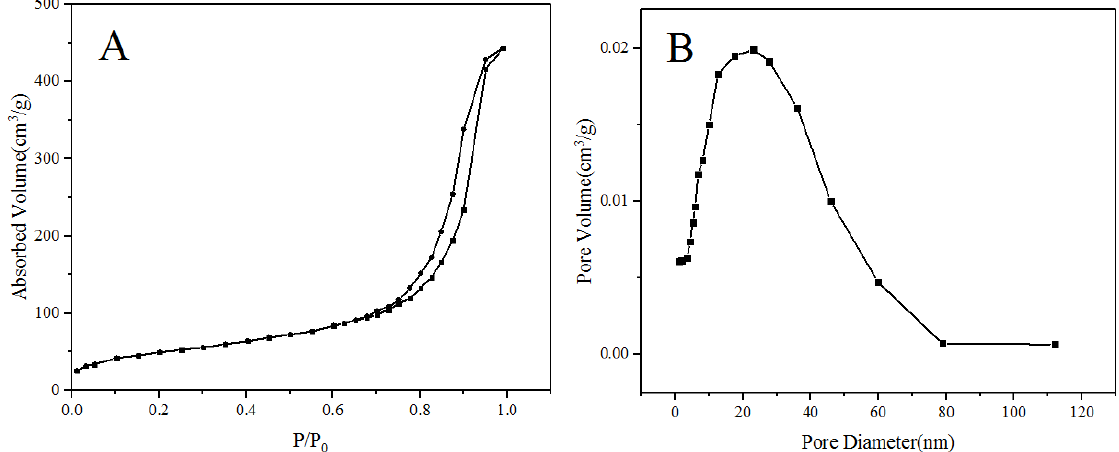
Figure 6: Nitrogen sorption isotherm (A) and pore size distribution (B) of PSMs